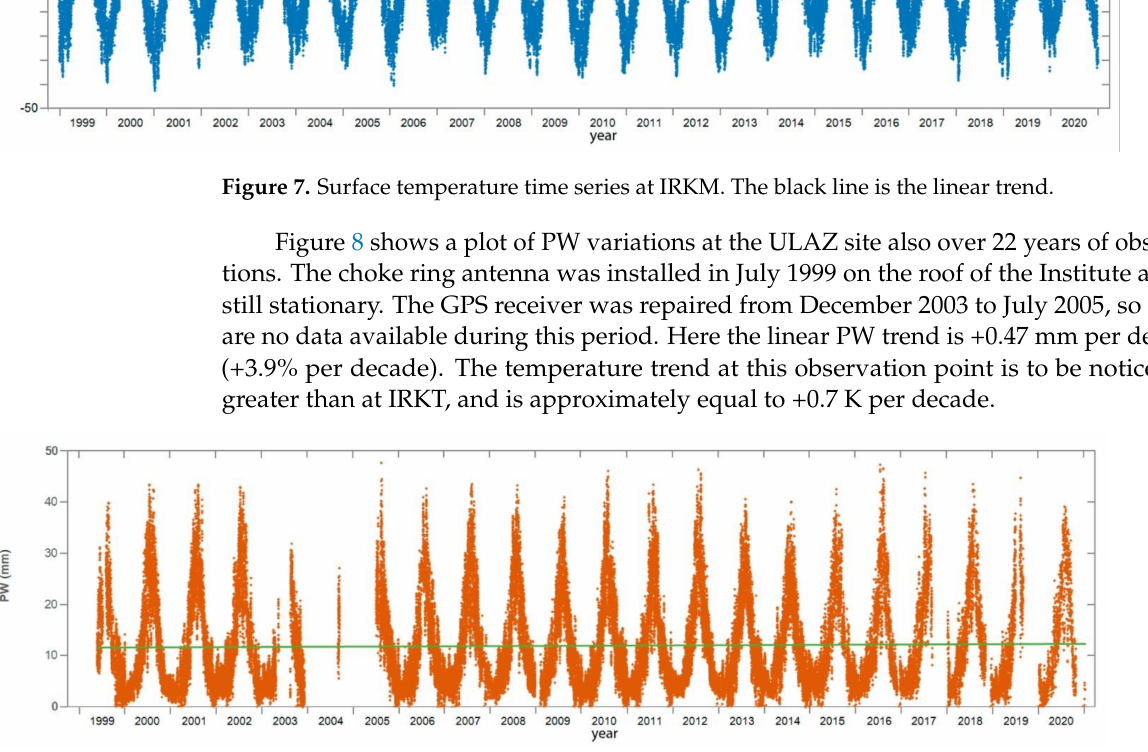
Figure 8. Time series of measured PW values at the ULAZ for the period 1999–2020. The green line is the general linear